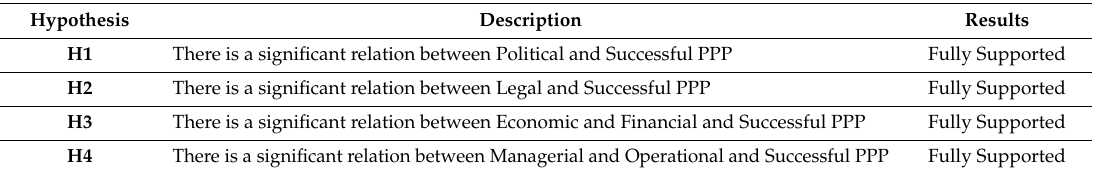
Table 12. Summary of research